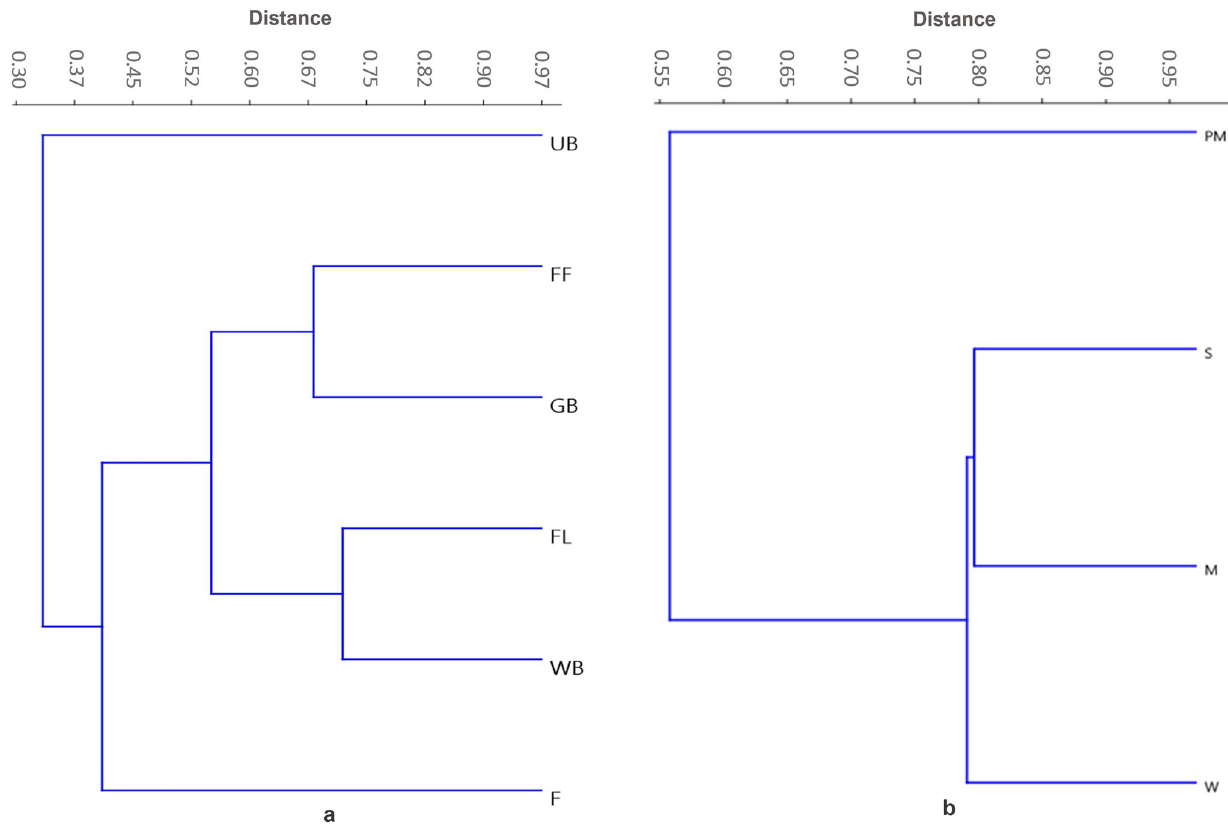
Fig 3. Abundance based Bray-curtis similarity linkages between (a) habitat types (b) seasons. FR: Undisturbed forests; FF: Forest farmland interfaces; FL: Farmlands; UB: Urban built-up areas; GB: Green belt and urban avenue plantations; WB: water bodies and buffer zones; PM: Post monsoon; S: Summer; M: Monsoon; W: